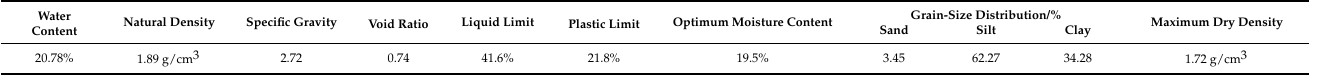
Table 1. Basic physical properties of the soil used in the